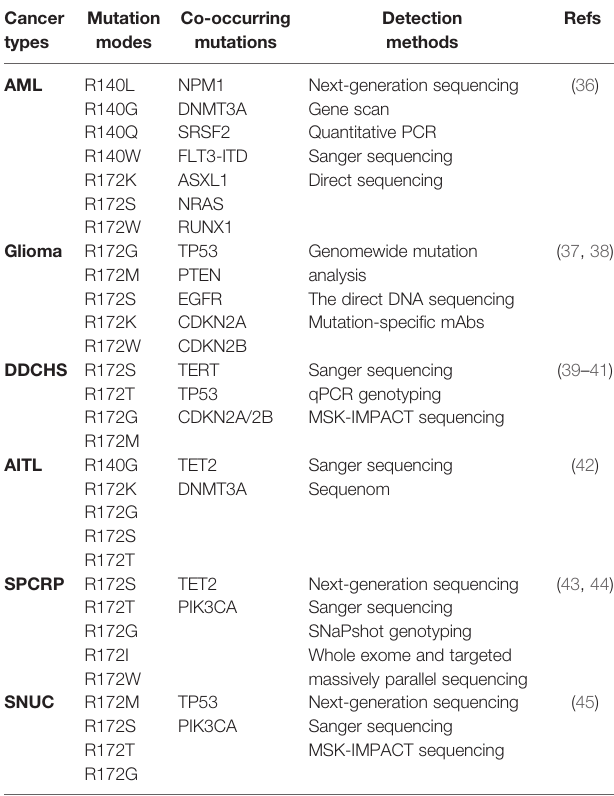
TABLE 2 | IDH2 Mutations in Human